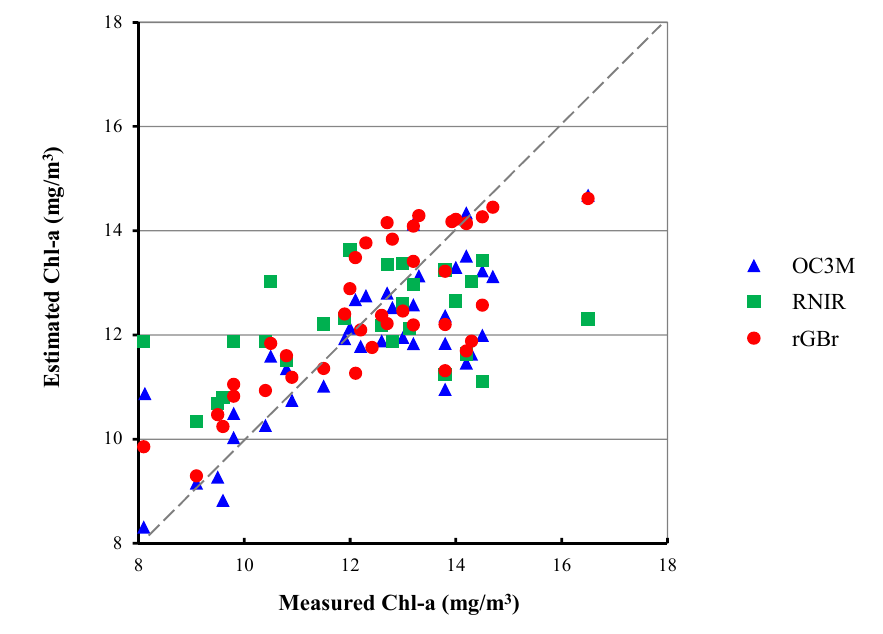
Figure 3. Scattergram of Chl-a concentrations between the sample value and estimation by three algorithms. The 45-degree dotted line denotes perfect